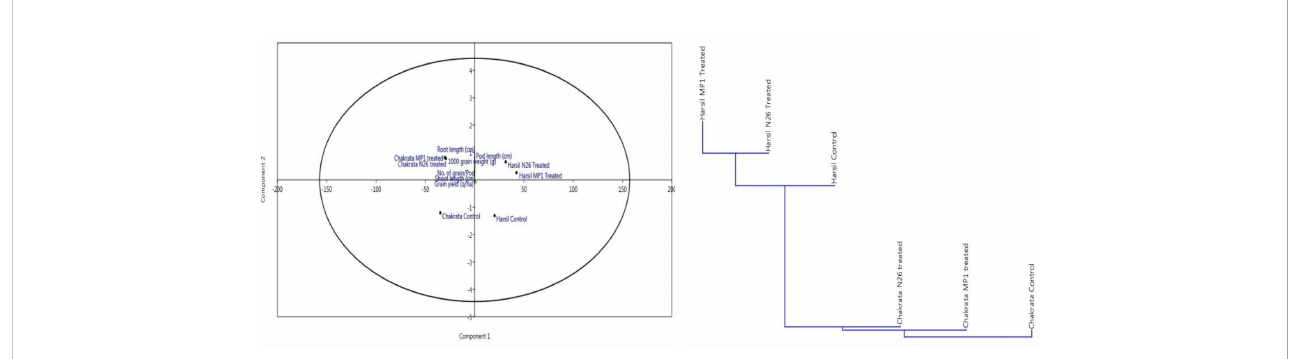
FIGURE 1 Principal component and cluster analysis depicting the effect of bioinoculants on agronomical parameters and their relative performance among treatments.